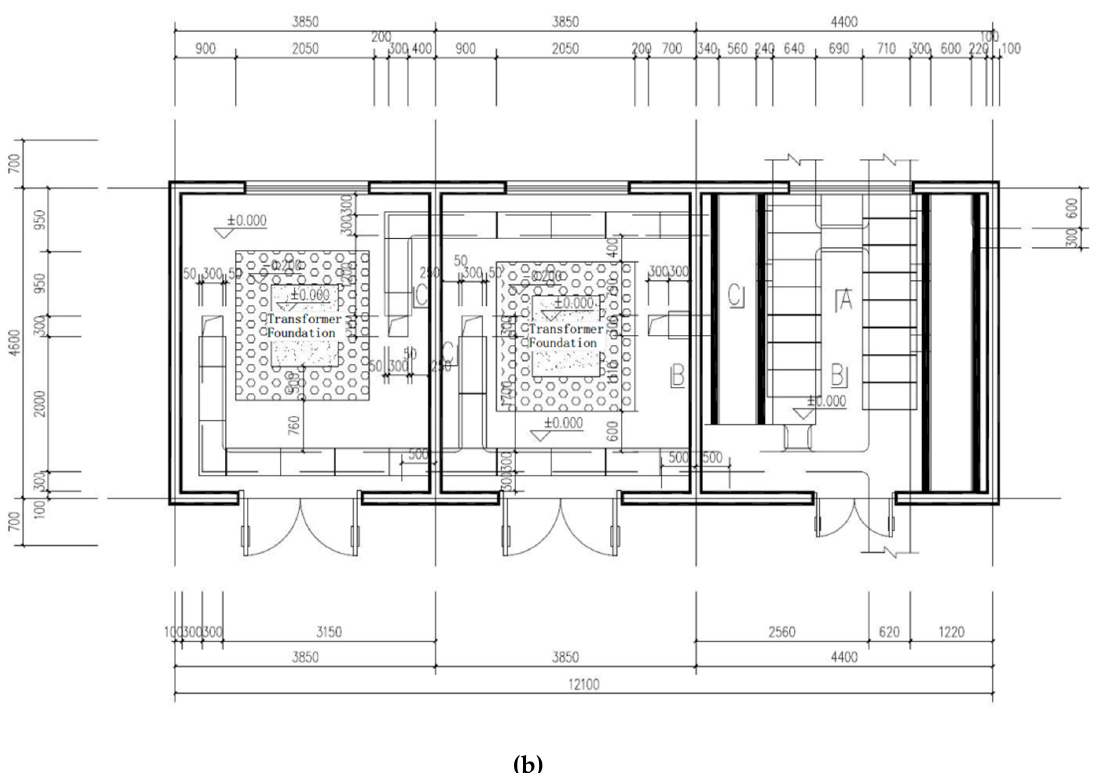
Figure 8. Plan view of 3D printed power distribution substation ( a ) Plan view of cable trench and ( b ) Plan view of cable trench.